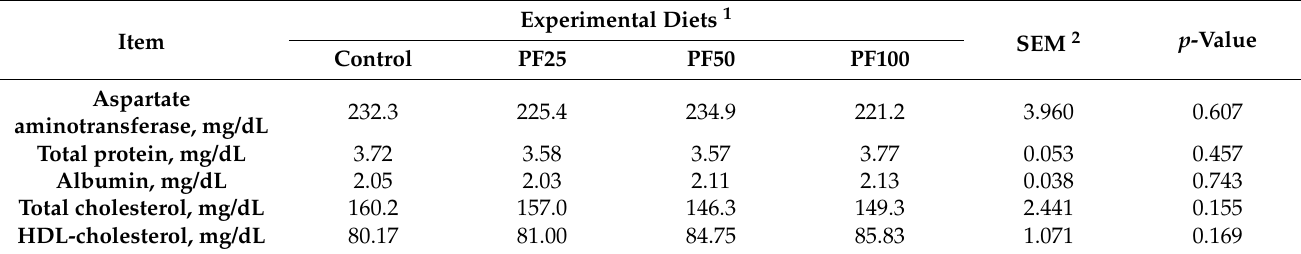
Table 5. Effect of replacing soybean oil with poultry fat on plasma biochemical parameters of broilers.